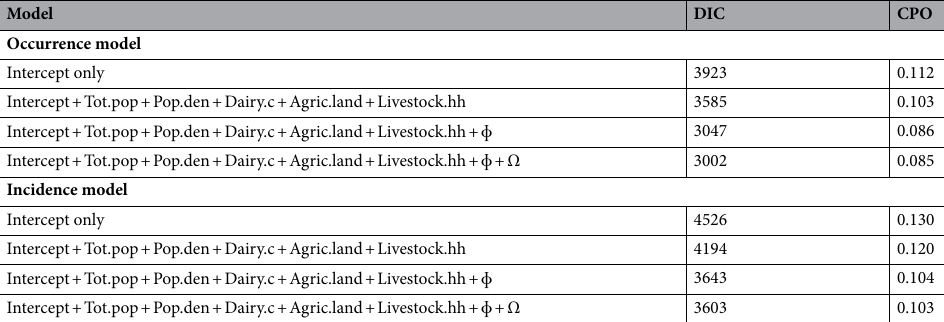
Table 5. Model comparison of the fitted INLA occurrence and incidence models using linear associations. Variables acronyms are Tot.pop Total population, Pop.den Population density, Dairy.c Exotic dairy cattle, Agric. land Agricultural land area, Livestock.hh Livestock producing households, ɸ Spatial random effect, Ω Temporal